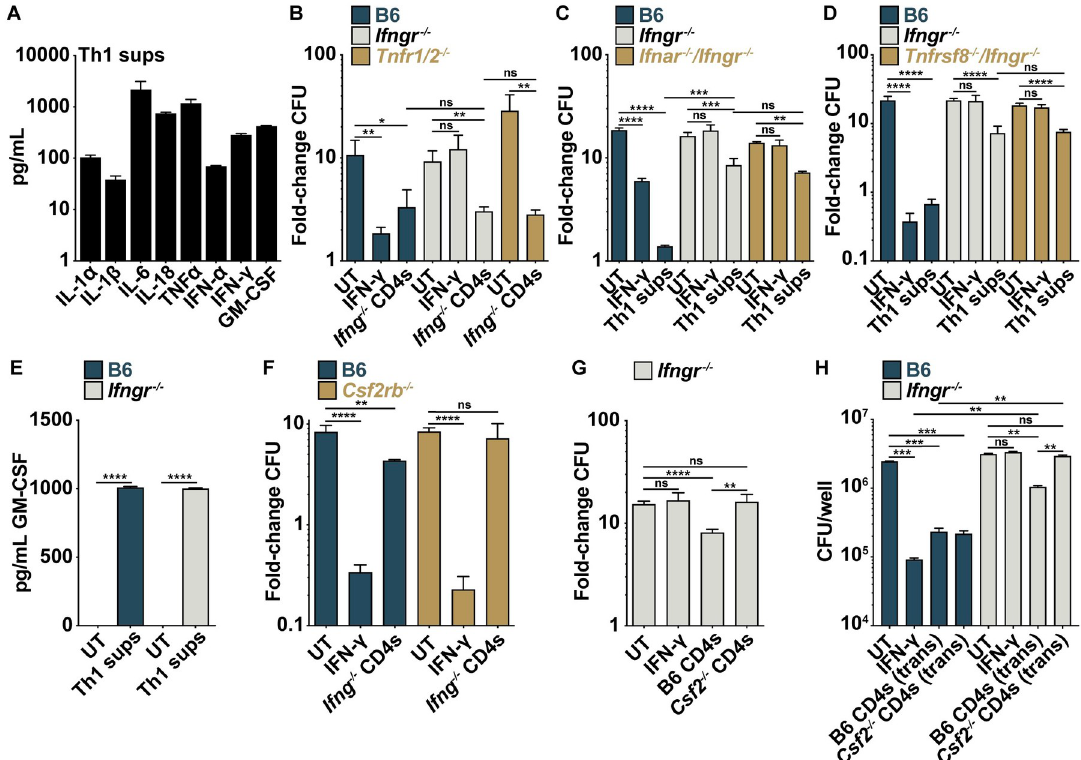
Fig 5. IFN- γ -independent control of M . tuberculosis requires CD4 T cell-derived GM-CSF. ( A ) Concentration of select cytokines in in vitro differentiated Th1 supernatants (sups). ( B ) CFU fold-change at d 5 postinfection for wild-type, Ifngr -/- , and Tnfr1/2 -/- BMDMs co-cultured with Ifng -/- lung-derived CD4 T cells. ( C ) CFU fold-change at d 5 postinfection for wild-type, Ifngr -/- , and Ifnar -/- / Ifngr -/- double-knockout BMDMs treated with Th1 sups. ( D ) CFU fold-change at d 5 postinfection for wild-type, Ifngr -/- and Tnfrsf8 -/- / Ifngr -/- double-knockout BMDMs treated with Th1 sups. ( E ) ELISA for GM-CSF concentration at 24 h postinfection in wild-type and Ifngr -/- BMDMs treated with Th1 sups. ( F ) CFU fold-change at d 5 postinfection for wild-type and Csf2rb -/- BMDMs co-cultured with Ifng -/- lung-derived CD4 T cells. ( G ) CFU fold-change at d 5 postinfection for Ifngr -/- BMDMs co-cultured with wild-type or Csf2 -/- lung- derived CD4 T cells. ( H ) CFU-fold change at d 4 postinfection for wild-type and Ifngr -/- BMDMs cultured with wild-type or Csf2 -/- lung- derived CD4 T cells in transwells. Figures represent seven (A) or three (E) biological replicates or are representative of two (B), (D), (H) or at least three (C), (F)-(G) independent experiments. Error bars are SD from seven (A) or three (B) biological replicates or four (B)- (D), (F)-(G) or three (H) replicate samples, � p < 0.05, �� p < 0.01, ��� p < 0.001, ���� p < 0.0001 by unpaired